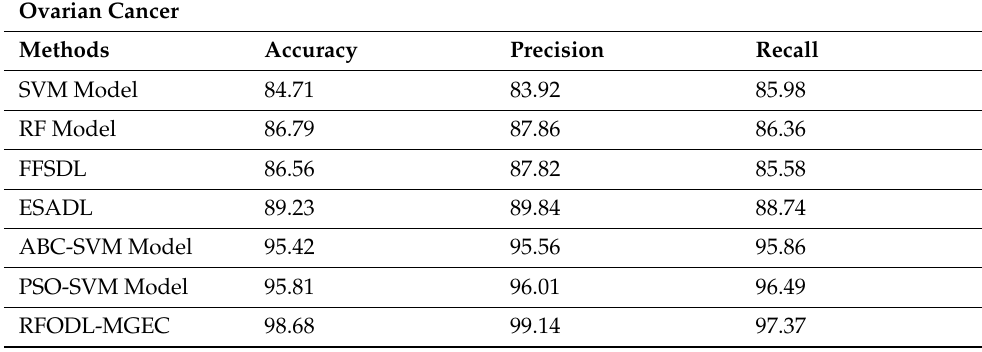
Table 7. Comparative analysis of RFODL-MGEC technique with recent algorithms for ovarian cancer dataset.